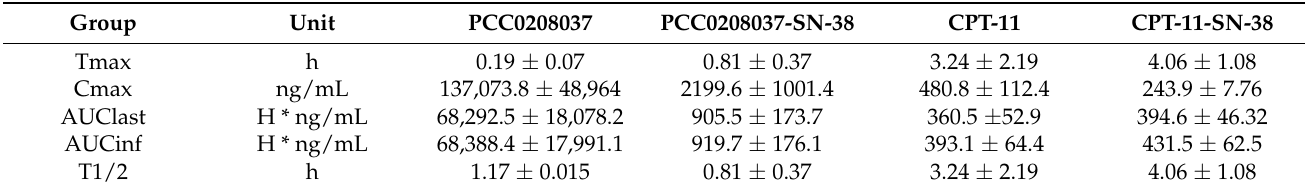
Table 3. The primary pharmacokinetic profile of PCC0208037 following a single intravenous dose in BALB/c